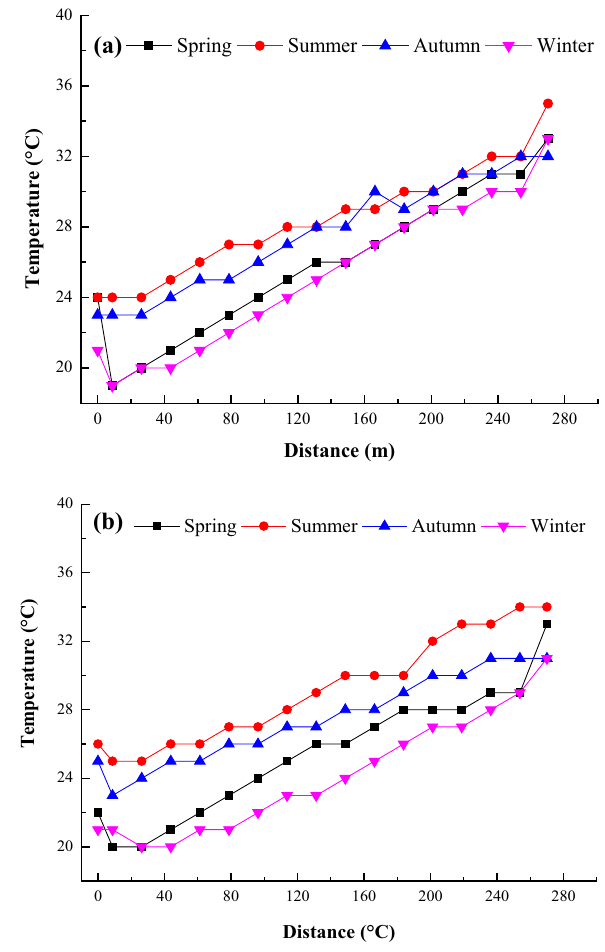
Fig. 8 Airflow temperature curves at different positions of the 2302S working face. a During maintenance, b during production. Note that the upper working face is designated as 0 m, and the lower working face is at 270